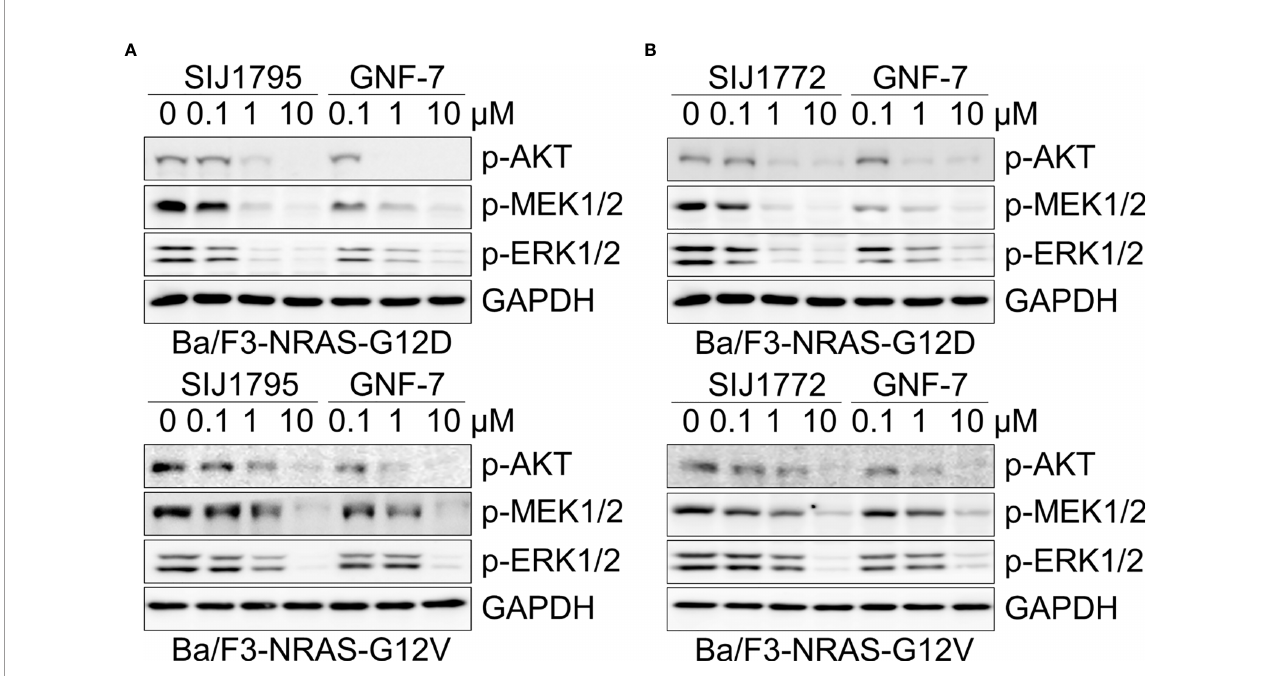
FIGURE 1 | The effects of (A) SIJ1795 and (B) SIJ1772 on MAPK and PI3K/AKT signaling pathways in Ba/F3 cells transformed with mtRAS (NRAS-G12D and NRAS-G12V). Cells were treated with 0.1, 1, and 10 m M of SIJ1795, SIJ1772, and GNF-7 for 2 h. Western blot analysis was conducted to evaluate the phospho- AKT, -MEK, -ERK levels. GAPDH was used as the loading